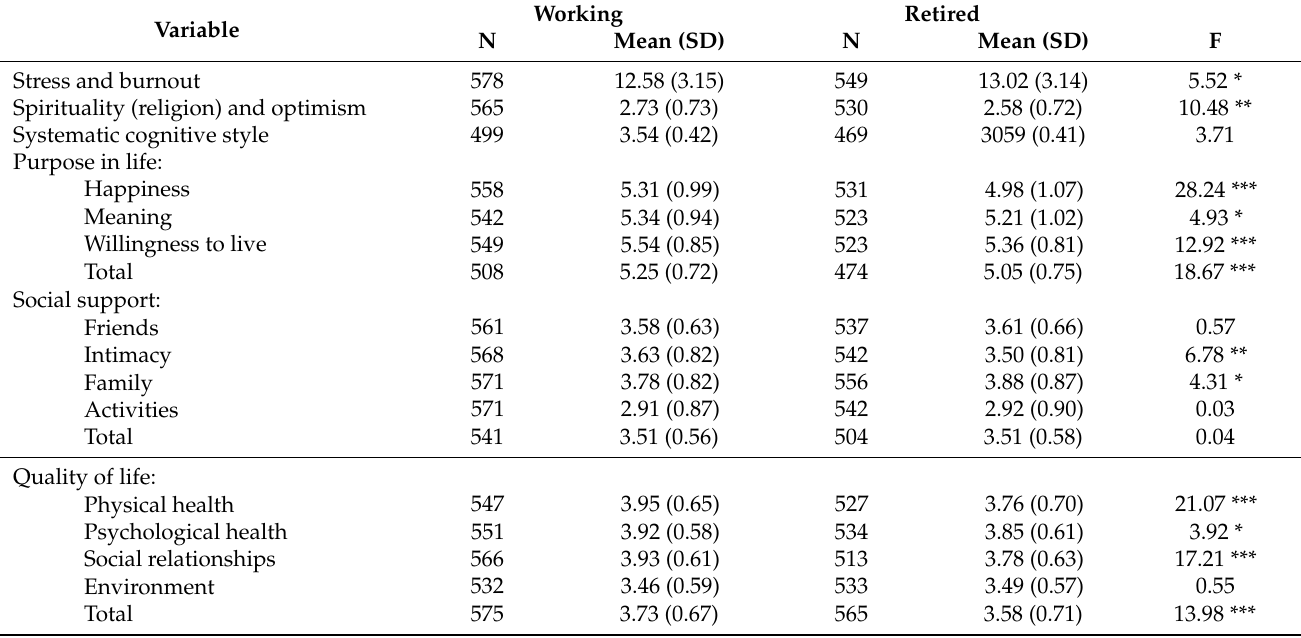
Table 3. Descriptive and F statistics of the studied variables regarding retirees and those who were working.